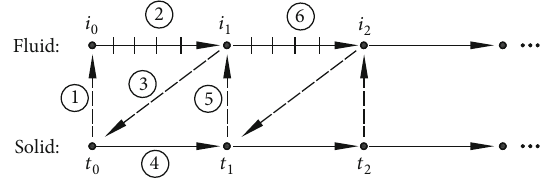
Figure 5: Two-way loosely coupling strategy.